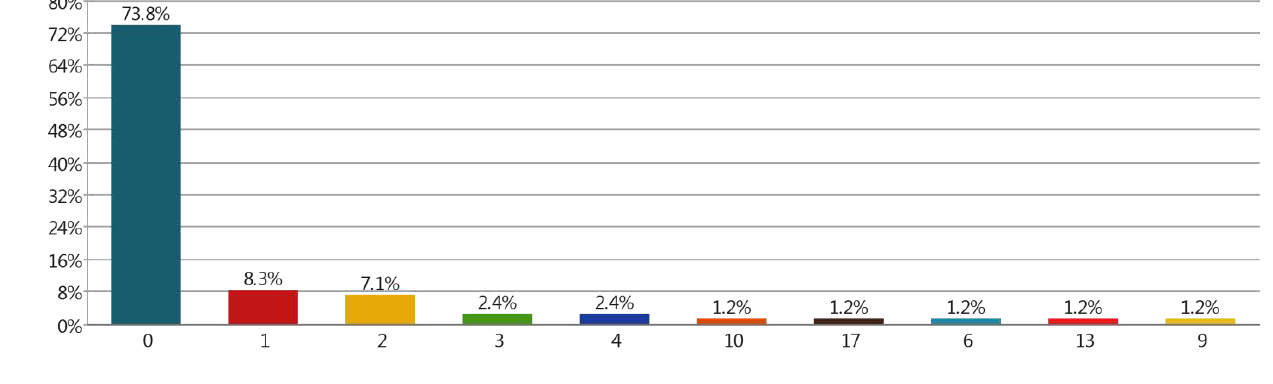
Figure 12. Data Security in